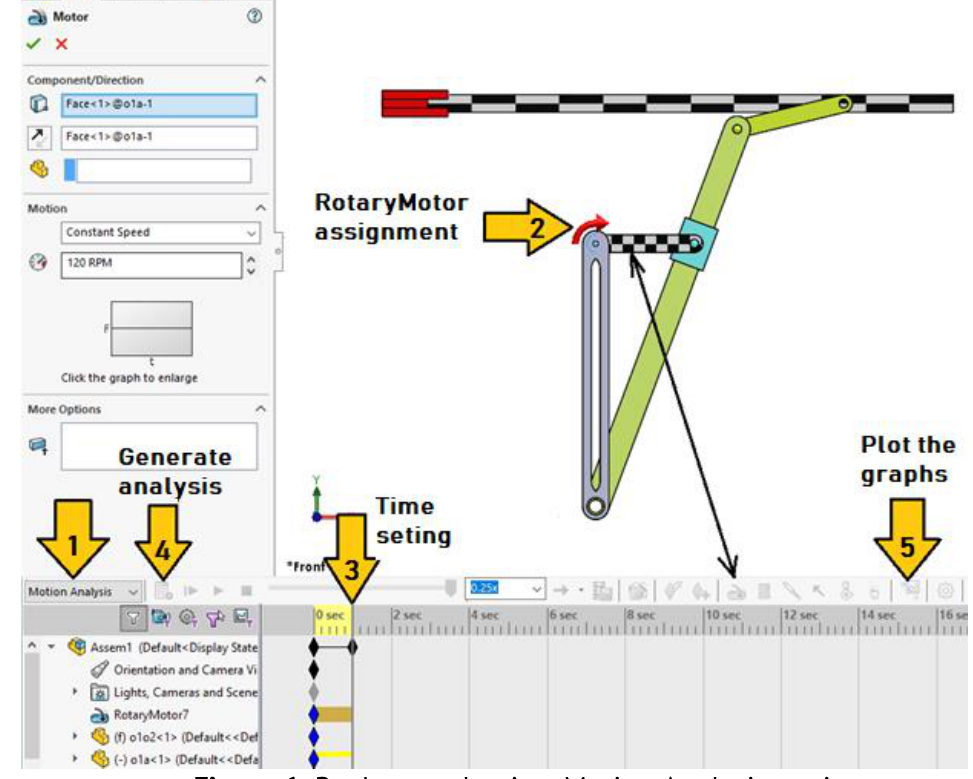
Figure 6. Rocker mechanism Motion Analysis settings.